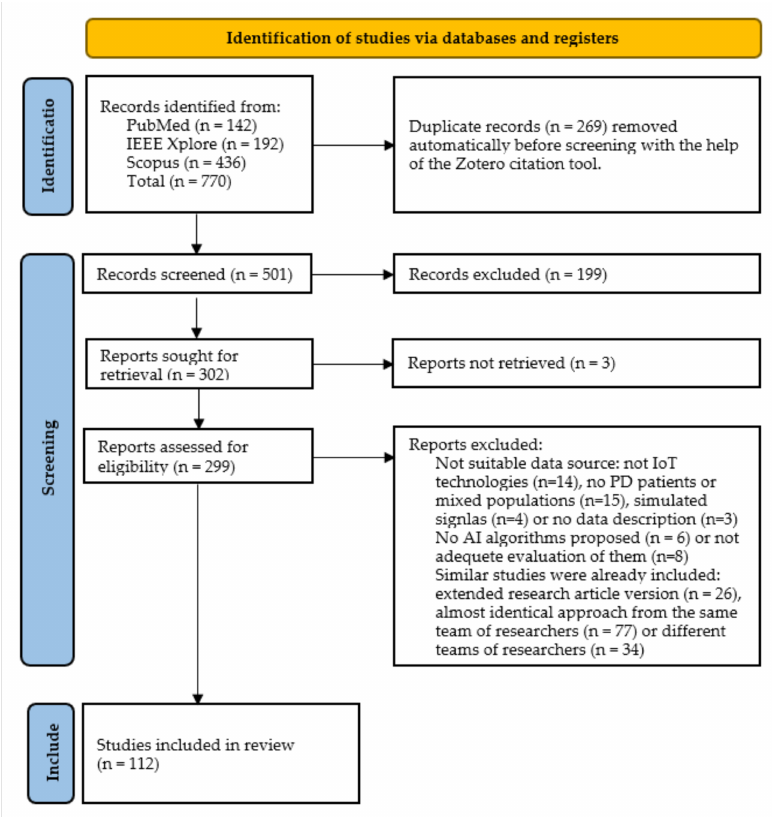
Figure 1. Flow diagram of the PRISMA methodology followed in the literature